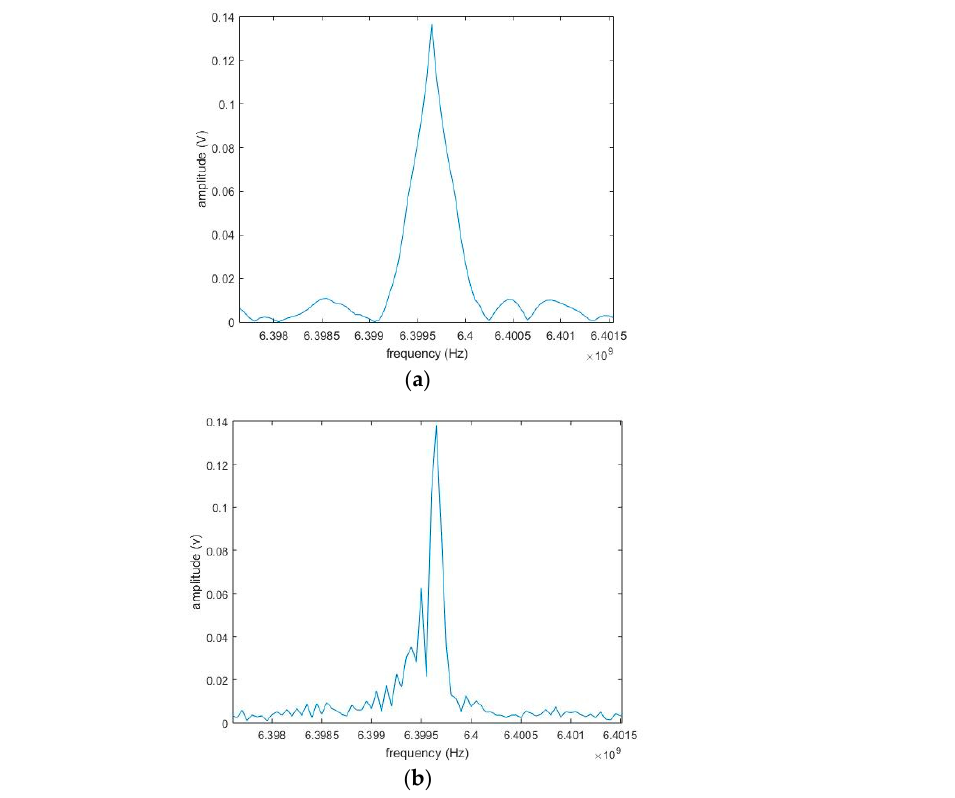
Figure 4. Frequency resolution of the output pulses using the classical time-domain pulse compression method ( a ) and the LPSA algorithm ( b ).